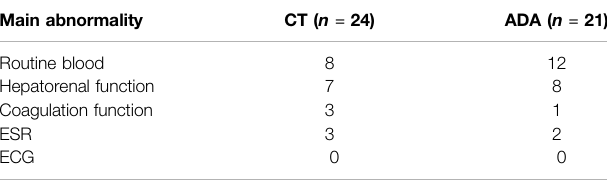
TABLE 4 | Serologic abnormalities in patients from different groups. Main abnormality